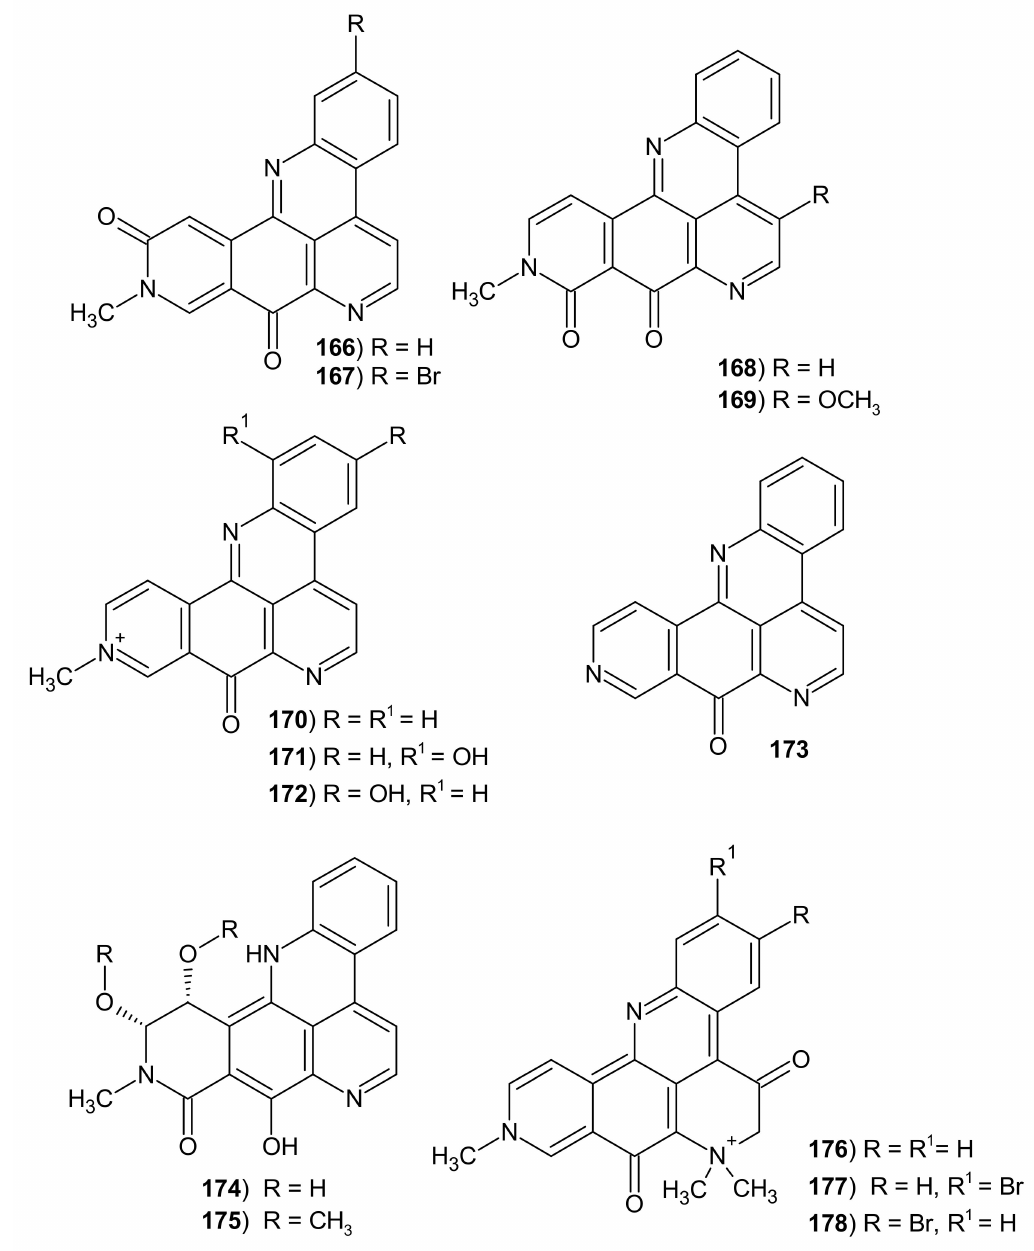
Figure 43. Alkaloids